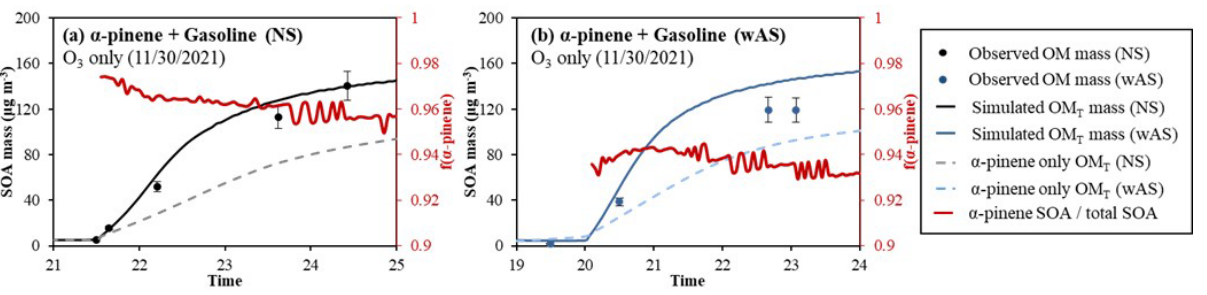
Figure 8. Observed (symbol) and simulated SOA mass (line) for the ozonolysis of α -pinene in the presence of gasoline fuel (a) without and (b) with wet-AS seed. SOA mass concentrations are corrected for the particle loss to the chamber wall. The simulated OM T (solid line) in the presence of gasoline fuel and that in the absence of gasoline fuel (dashed line) are also illustrated. The dashed lines denote the simulated SOA mass in the absence of gasoline fuel under the same experimental conditions. The fractions of α -pinene SOA to total SOA ( f ( α -pinene)) are illustrated by red lines. The error (10%) associated with SOA mass was estimated with the instrumental